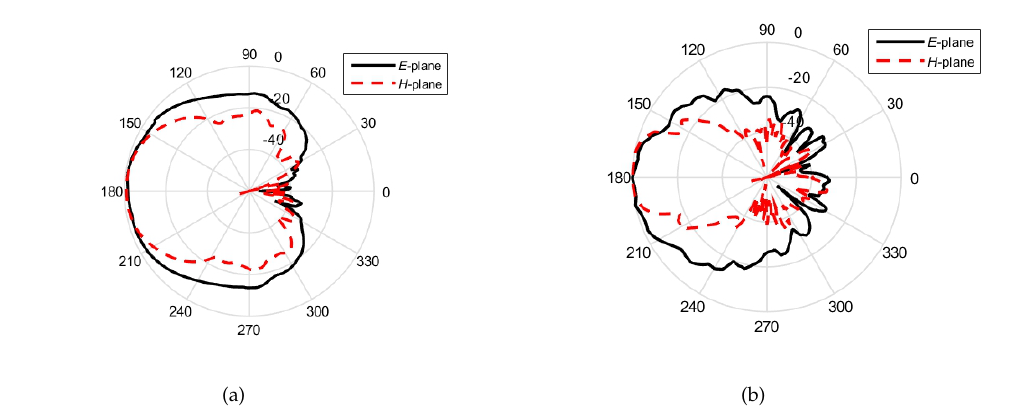
Figure 1. (color online) Radiation patterns of antennas at ( a ) 3.6 GHz; and ( b ) 14.6 GHz.